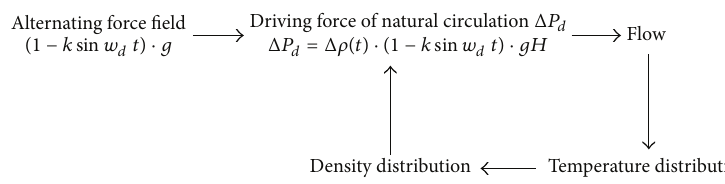
Figure 7: Relationship chain of factors affecting natural circulation in heaving motion.